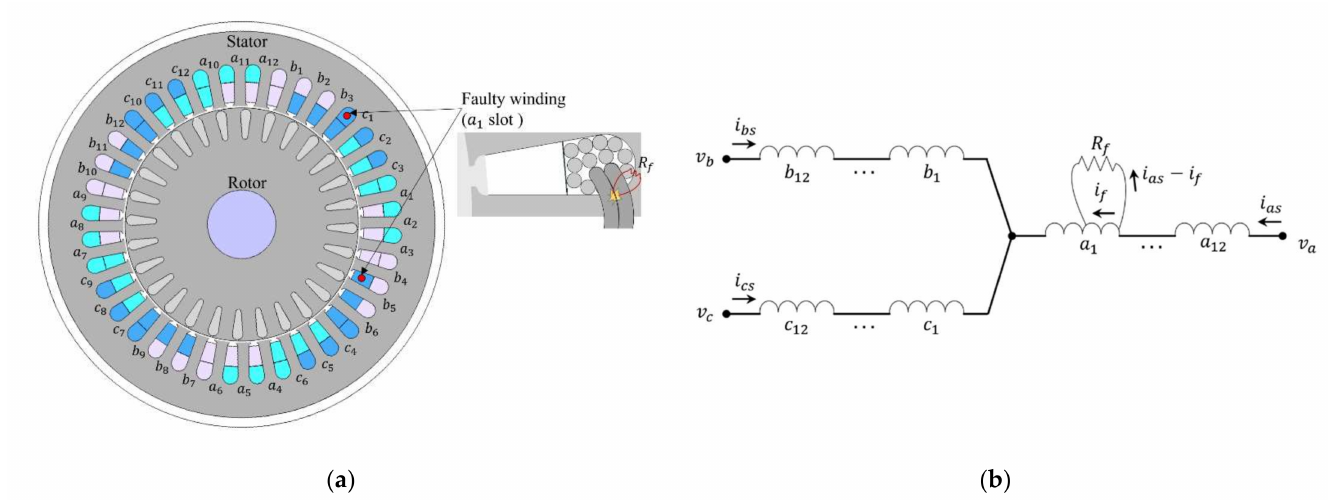
Figure 1. ( a ) 4-pole 36-slot induction motor cross-sectional figure. ( b ) series connected winding configuration with an